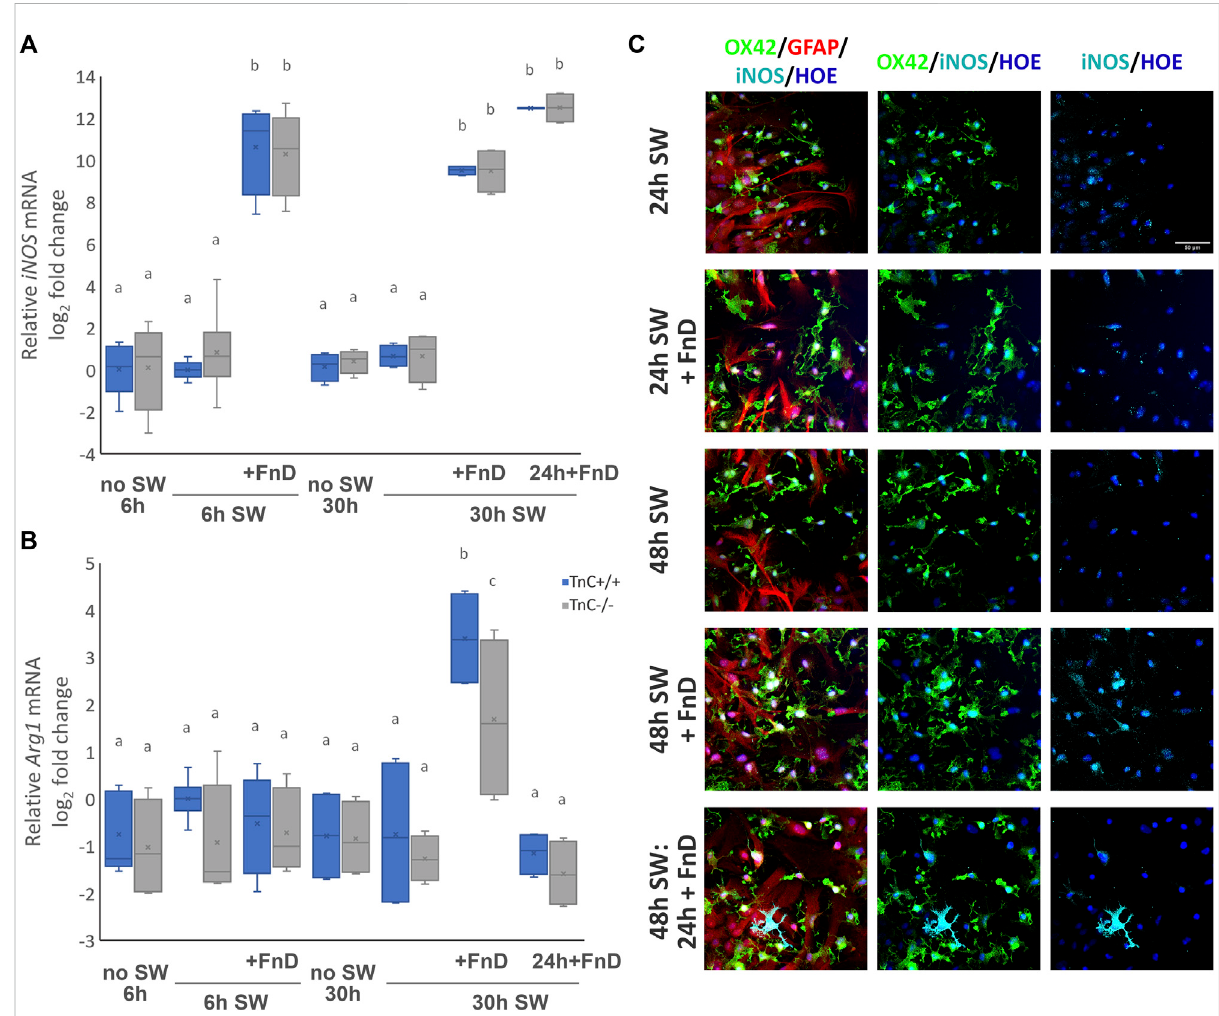
FIGURE 6 FnD treatment upregulates expression of iNOS at all timepoints and Arg1 at 30h upon SW. Box — whisker plots of relative iNOS mRNA log 2 fold change (A) and relative Arg 1 mRNA log2 fold change (B) are shown. Two-way ANOVA was used to test statistical signi fi cance. Pairwise comparisons are denoted with letters, shared letters imply no signi fi cant difference between groups. Actual p values are indicated in the text (n = 3 independent cultures, performed in duplicate). Representative micrographs of immuno fl uorescently labelled OX42 (green), marker of microglia, GFAP (red) marker of astrocytes, iNOS (cyan) and Hoechst (blue) nuclear marker (C) . Strong iNOS immunoreactivity was observed on some microglial cells in group 48 h SW: 24 h + FnD in both genotypes in the gap area (only wild-type